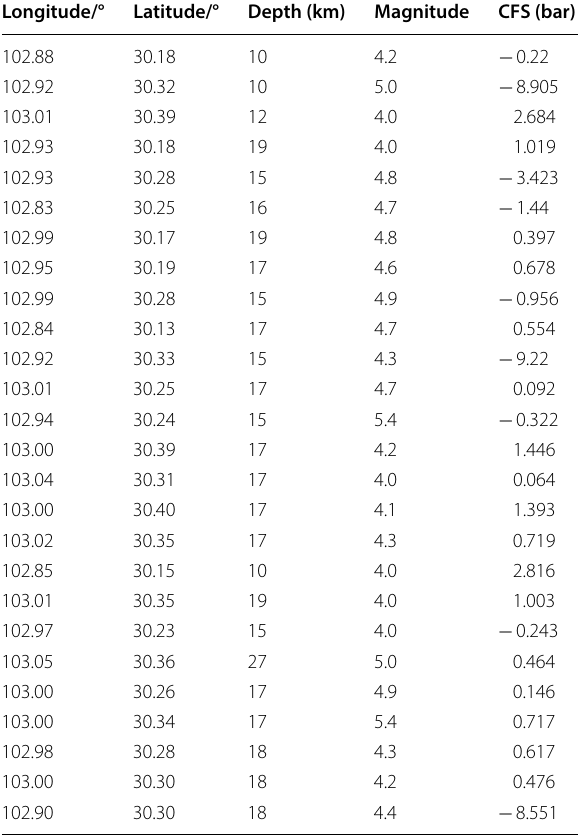
Table 3 Catalog of the 2017 Jiuzhaigou aftershocks from CENC